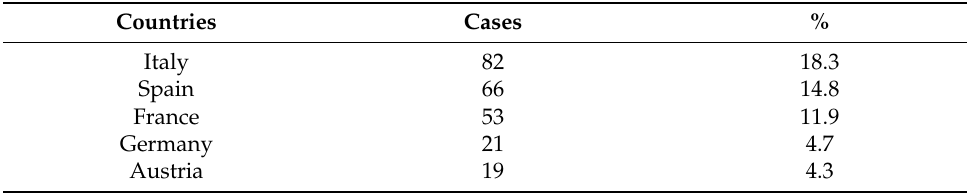
Table 2. Numbers and percentages of top 5 countries.